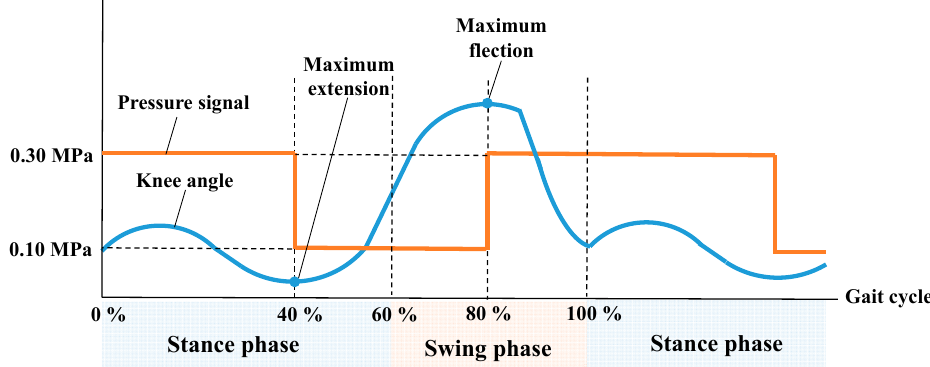
Figure 14. Image of the relationship between the target pressure on the device and the knee joint angle during gait motion. It represents the ideal assist pattern switching and subject movement.